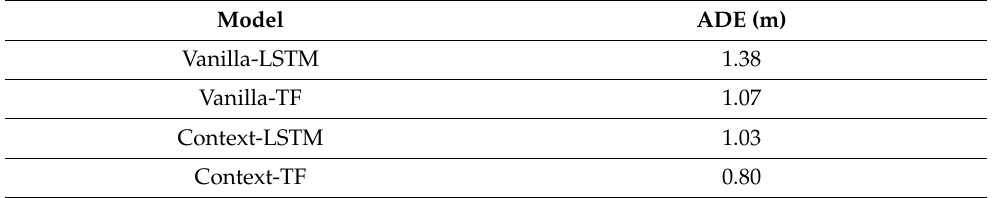
Table 9. Performance of pedestrian trajectory prediction models on the inD dataset reported in [34].